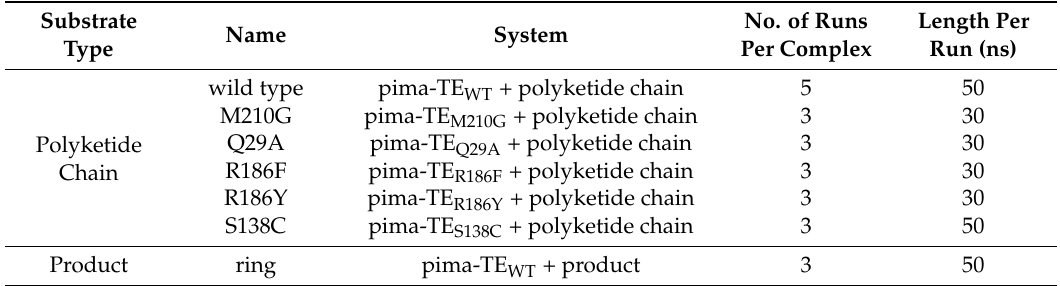
Table 1. List of MD Runs